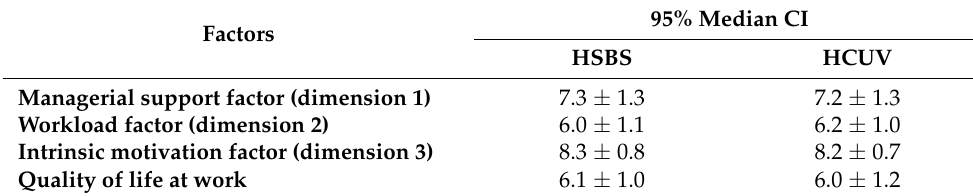
Table 4. Overall median score for each dimension of the CVP-35 questionnaire in the nursing staff in both hospitals (HSBS and HCUV). The 95% confidence interval (CI) of the median, calculated by bootstrap, is